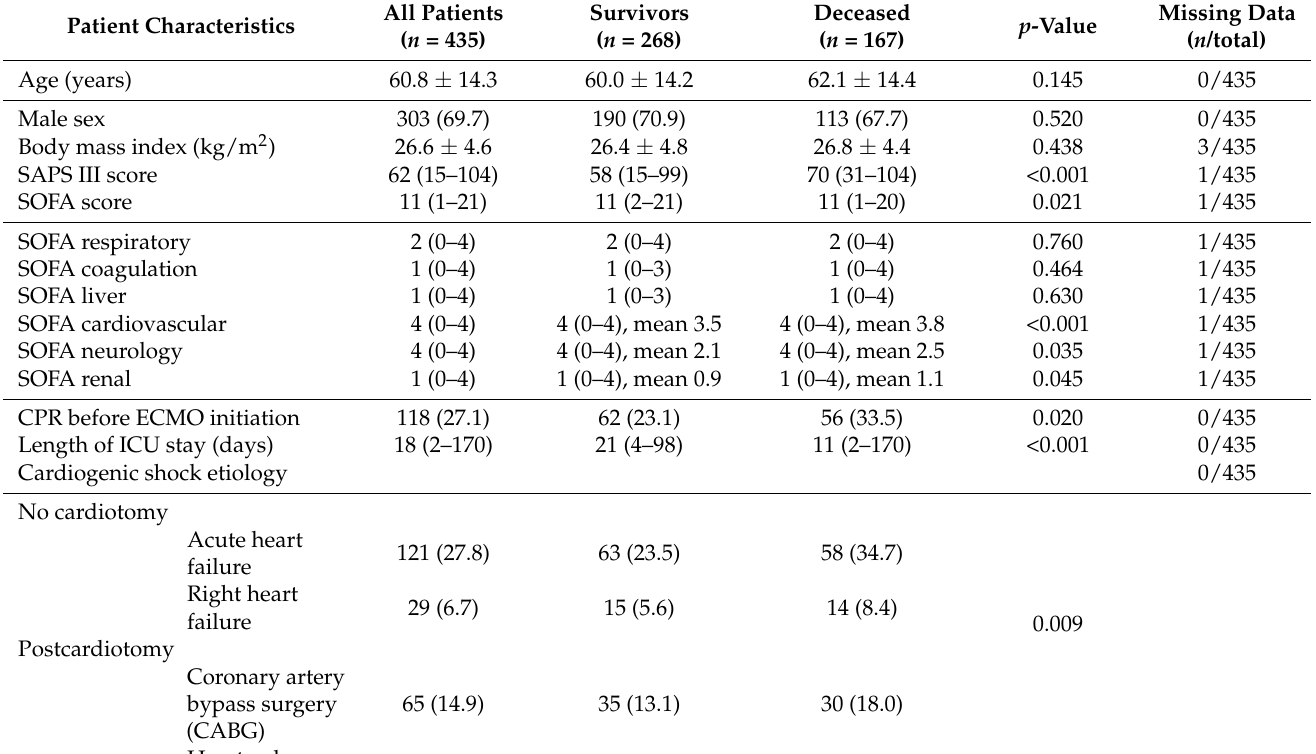
Table 1. Demographic and clinical characteristics of patients with cardiogenic shock ( n =